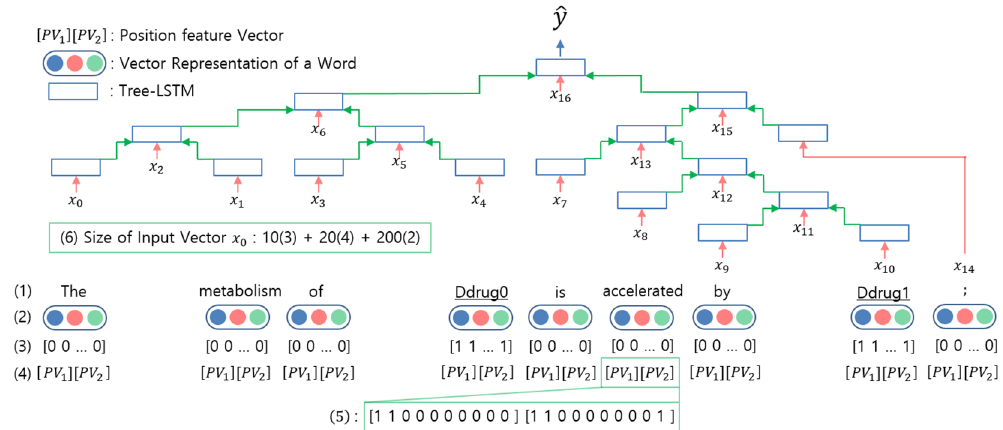
Fig 2. The architecture of our recursive neural network model. Our model is a variation of the binary tree-LSTM model. (1) The words in a sentence. The names of drug targets are underlined. (2) Vector representation of a word through the word embedding lookup process. (3) Subtree containment feature represents the importance of a node. (4) Position feature vector representing the relative distance of two target drugs from the current word position. (5) An example of the position feature vector. The current word is “accelerated.” (6) The size of the concatenated vector input x 0 of our model is 10 (size of the subtree containment feature; (3) in the figure) + 20 (size of the position feature; (4) in the figure) + 200 (size of the word embedding; (2) in the